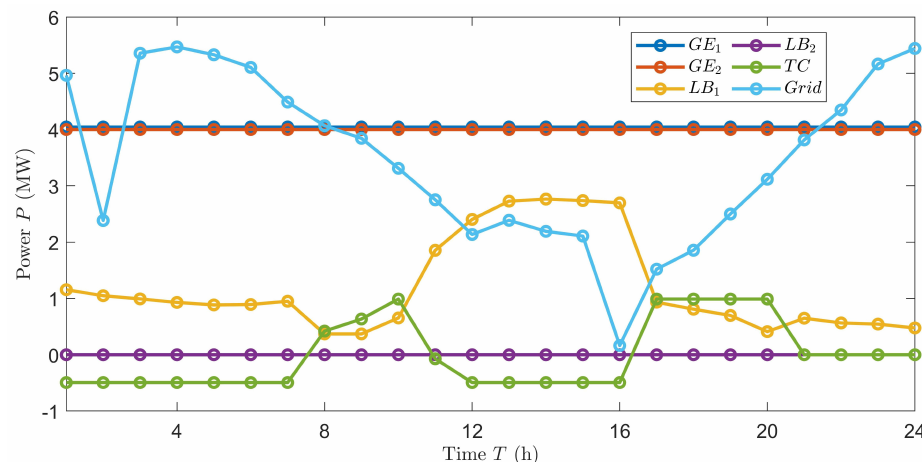
Figure 9. Equipment output (heating season, determining heat by